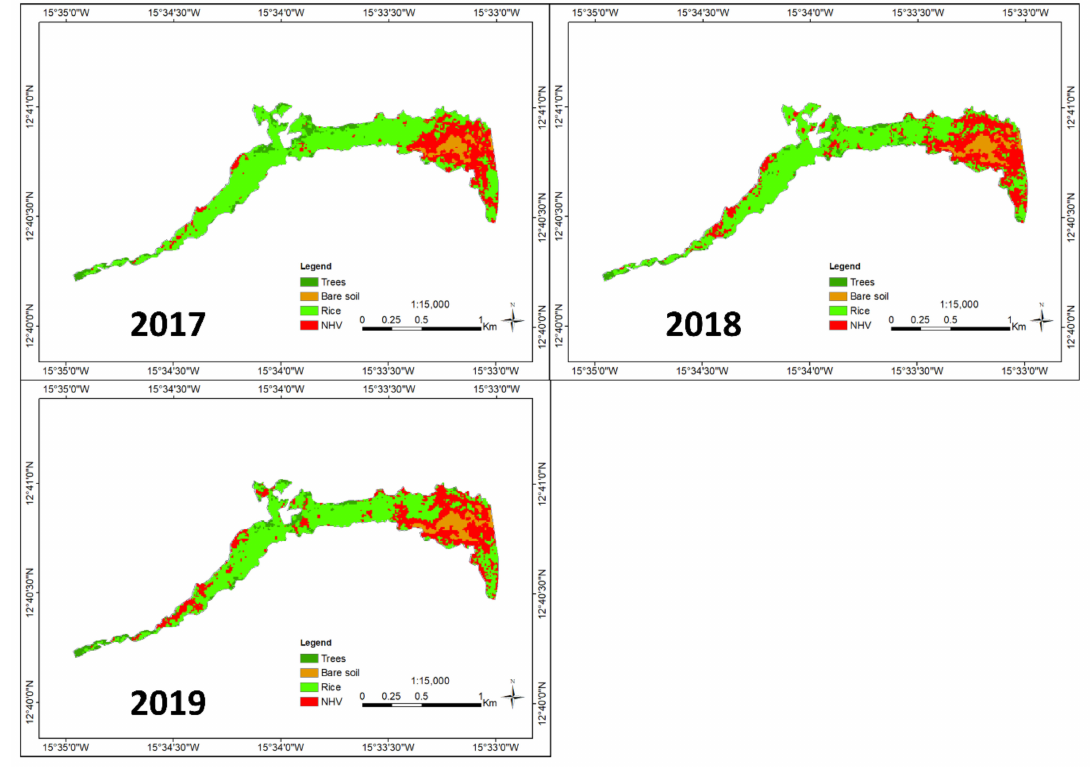
Figure 12. Classification of Samiron valley in 2017, 2018, and 2019 rice growing